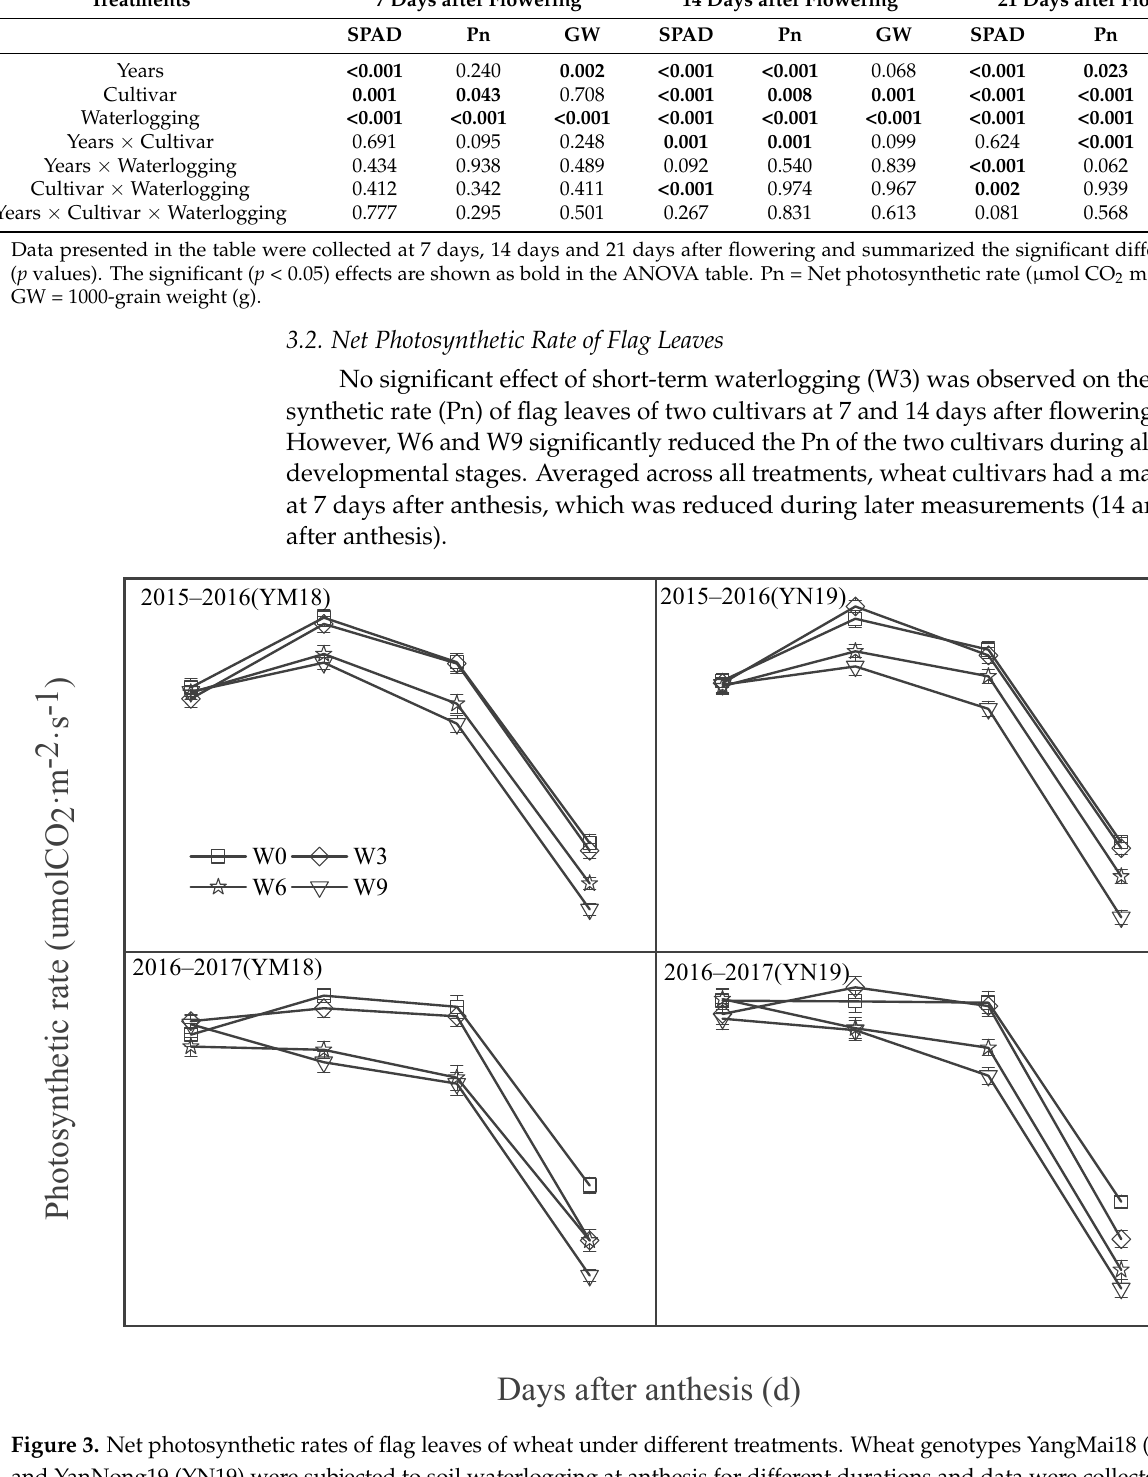
Figure 3. Net photosynthetic rates of flag leaves of wheat under different treatments. Wheat genotypes YangMai18 (YM18) and YanNong19 (YN19) were subjected to soil waterlogging at anthesis for different durations and data were collected at 0, 7, 14 and 21 days after anthesis. W0 = control, W3 = 3 days of waterlogging, W6 = 6 days of waterlogging, W9 = 9 days of waterlogging. Each data point represents the mean ± SE of three independent replicates.